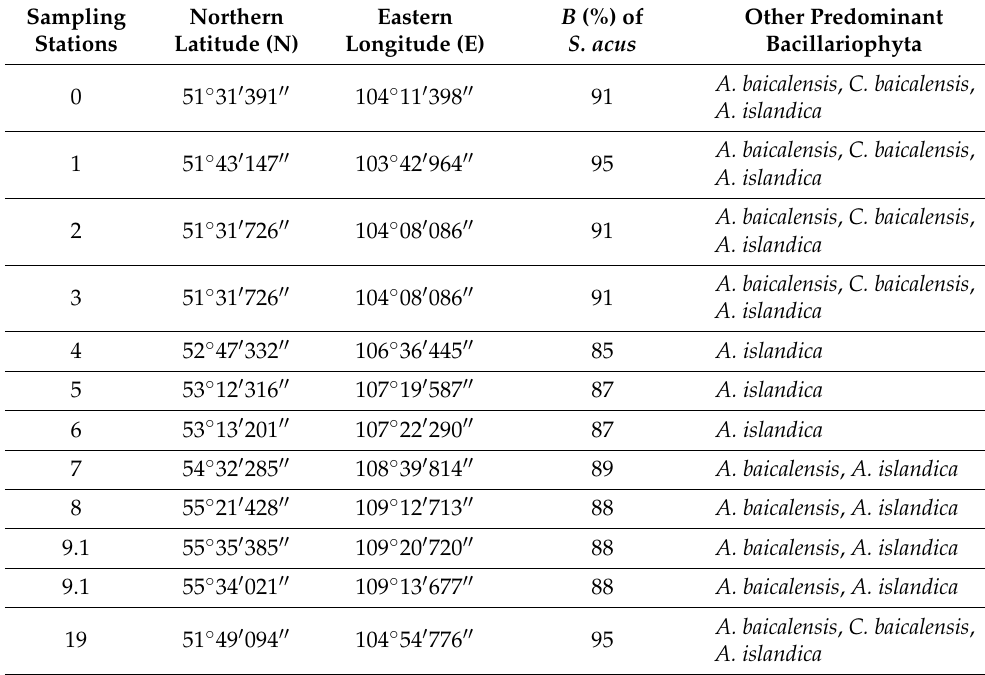
Table 3. Contribution of S. acus to total coastal phytoplankton biomass during spring season